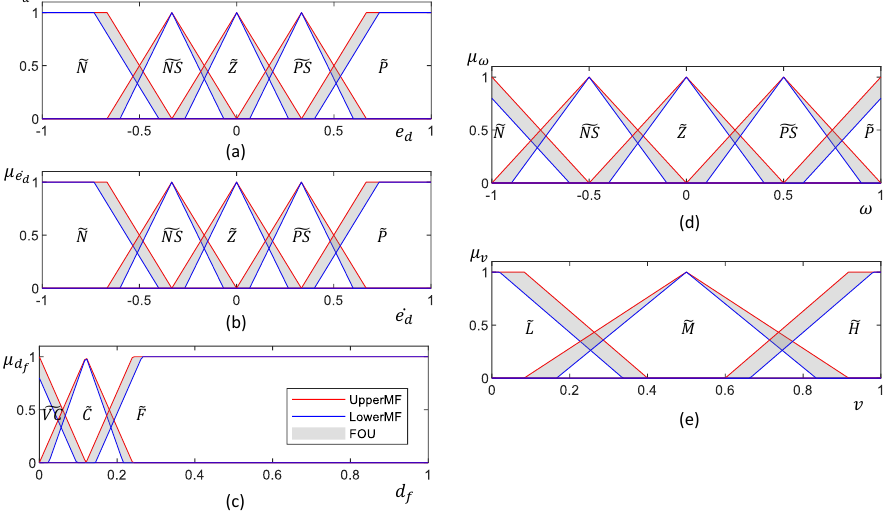
Figure 6. Membership functions of the IT2-FLS. ( a – c ) Input membership function for e d , ˙ e d , and d f , respectively. ( d , e ) Output membership function for ω and v , respectively. The upper membership function and lower membership function of each fuzzy set are annotated as UpperMF and LowerMF. The Footprint Of Uncertainty (FOU) is represented by the shaded area. Fuzzy labels are defined as N: “Negative,” NS: “Negative Small,” Z: “Zero,” PS: “Positive Small,” P: “Positive,” VC: “Very